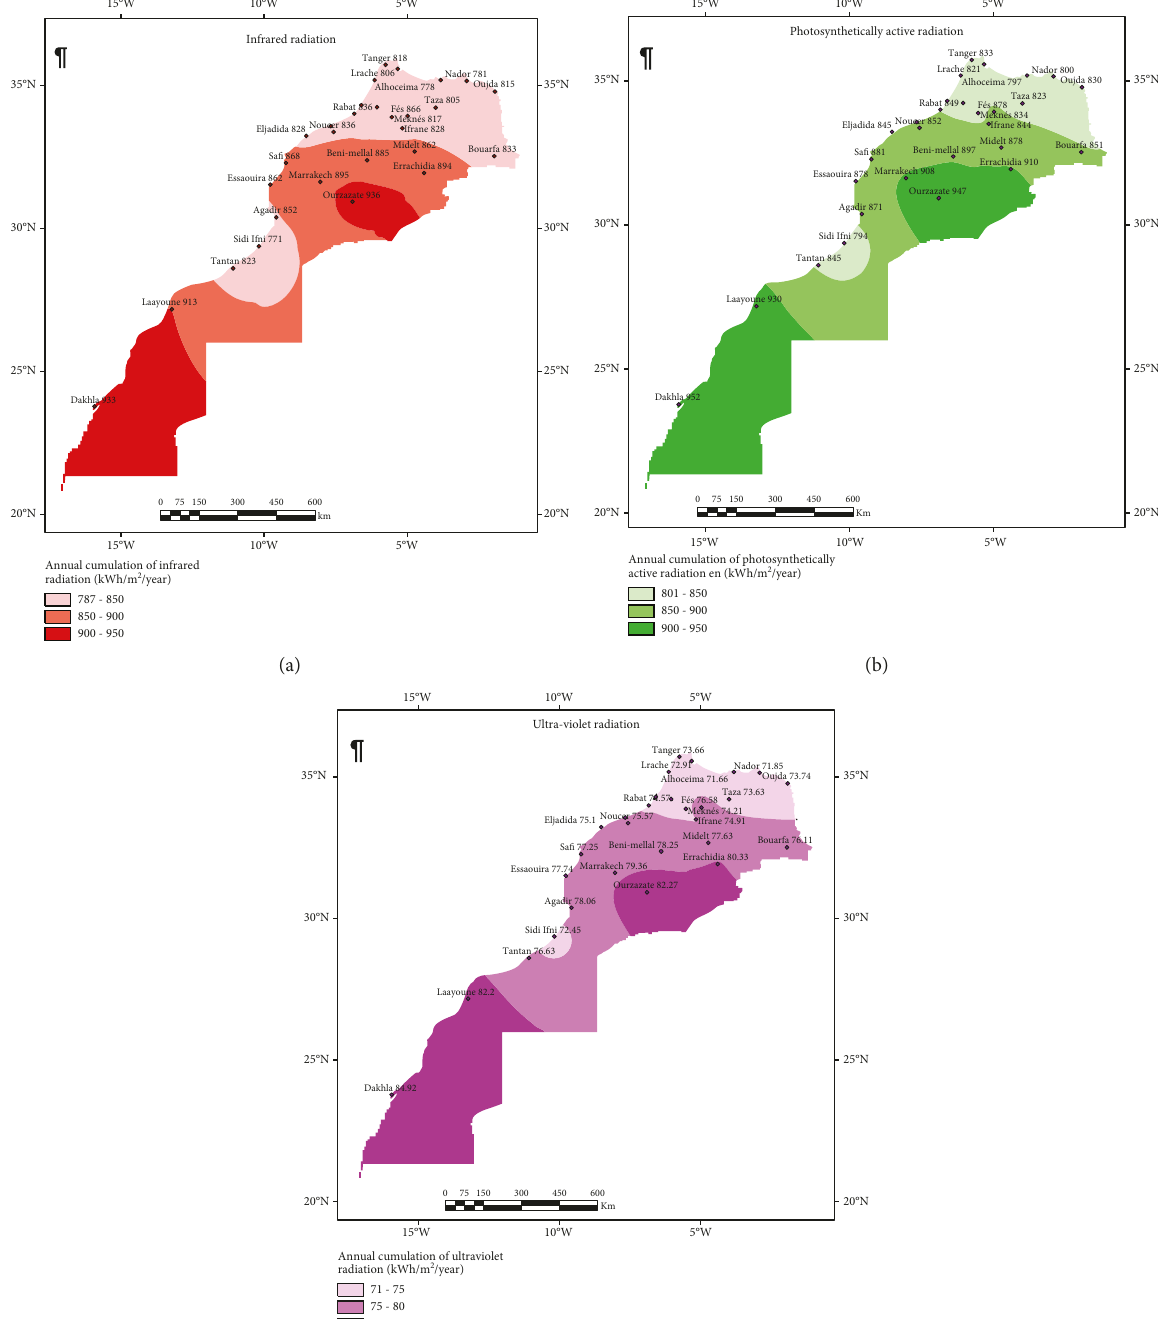
Figure 13: Maps of the annual cumulation of daily irradiations of the spectral components of solar radiation ( H horizontal plane incident in the Moroccan territory. Maps of solar radiation spectral components (a –